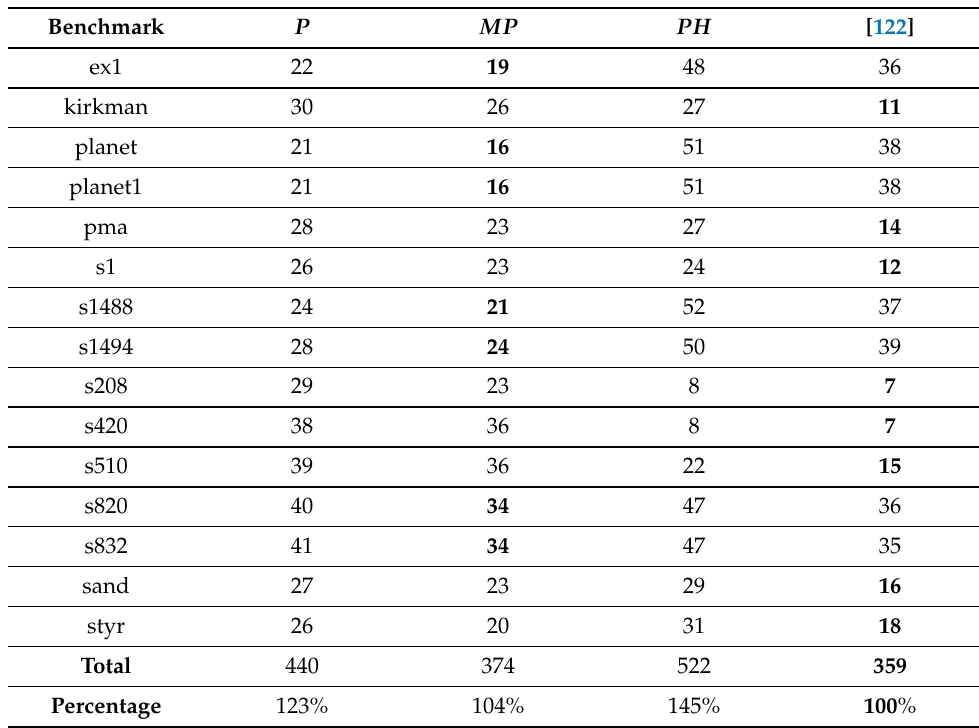
Table 13. Experimental results [122] (LUT counts).